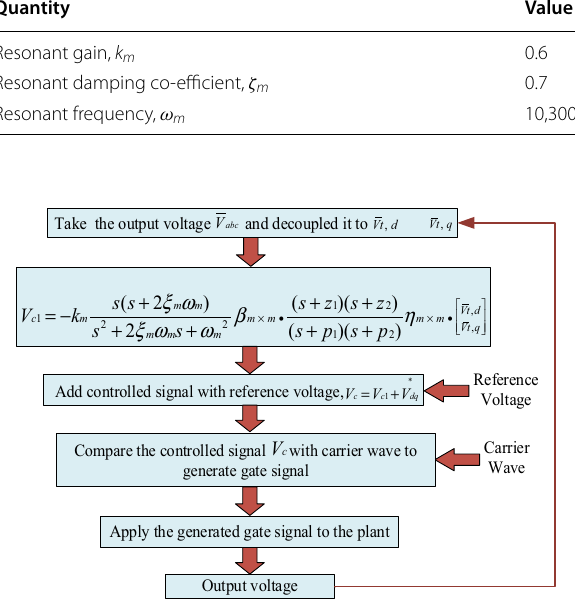
Fig. 5 Flowchart of designed NI‑RLLC controller incorporating nominal plant